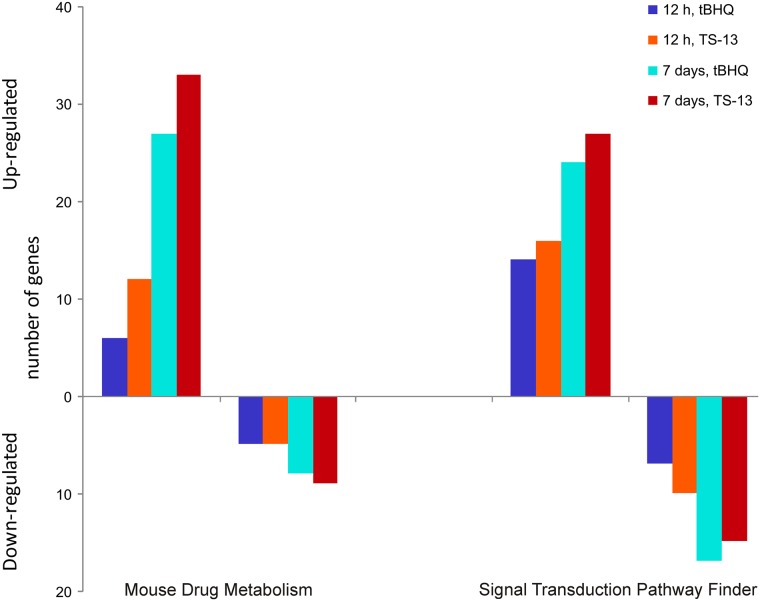
A summary of genes modulated (more than 1.5-fold) by tBHQ or TS-13 in the mouse liver.Hepatic gene expression patterns were analyzed after 12 h or 7 days of administration of tBHQ or TS-13.